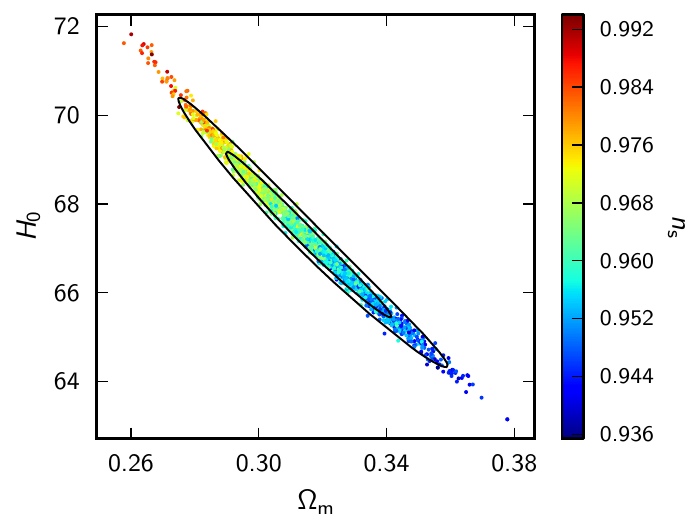
Figure 9: The allowed range of the parameters 𝐻 0 , Ω m , from the 2013 Planck data, is shown as a series of points. A flat Universe is assumed, together with information from the Planck fluctuation temperature spectrum, CMB lensing information from Planck , and WMAP polarization observations. The colour coding reflects different values of 𝑛 𝑠 , the spectral index of scalar perturbations as a function of spatial scale at early times. Image reproduced with permission from [2], copyright by